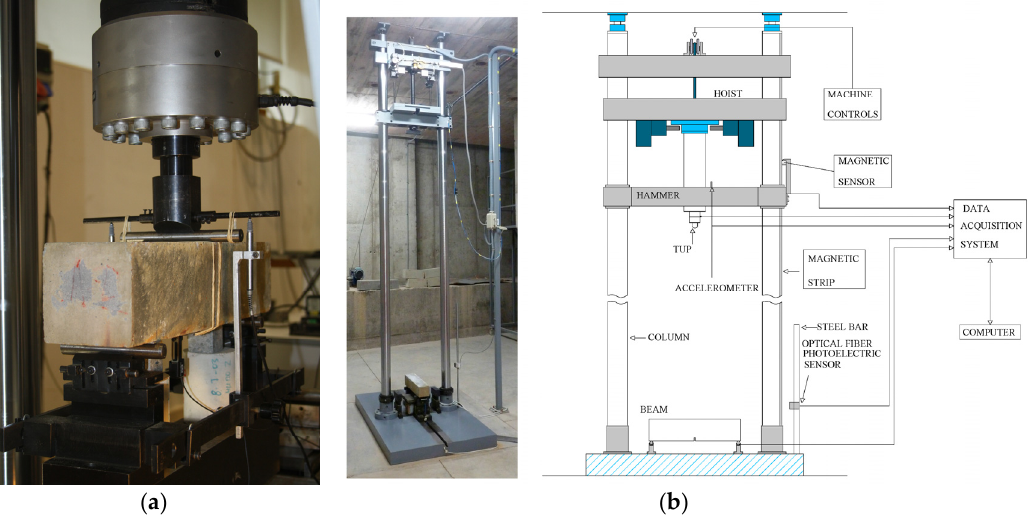
Figure 3. ( a ) Photo of the servo-hydraulic testing machine; ( b ) photo and schematic diagram of the drop-weight impact machine.